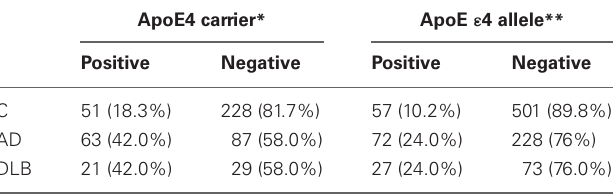
Table 1 | Distribution of ApoE4 carrier status and the frequency of ApoE ε 4 allele in the population of AD, DLB, and control